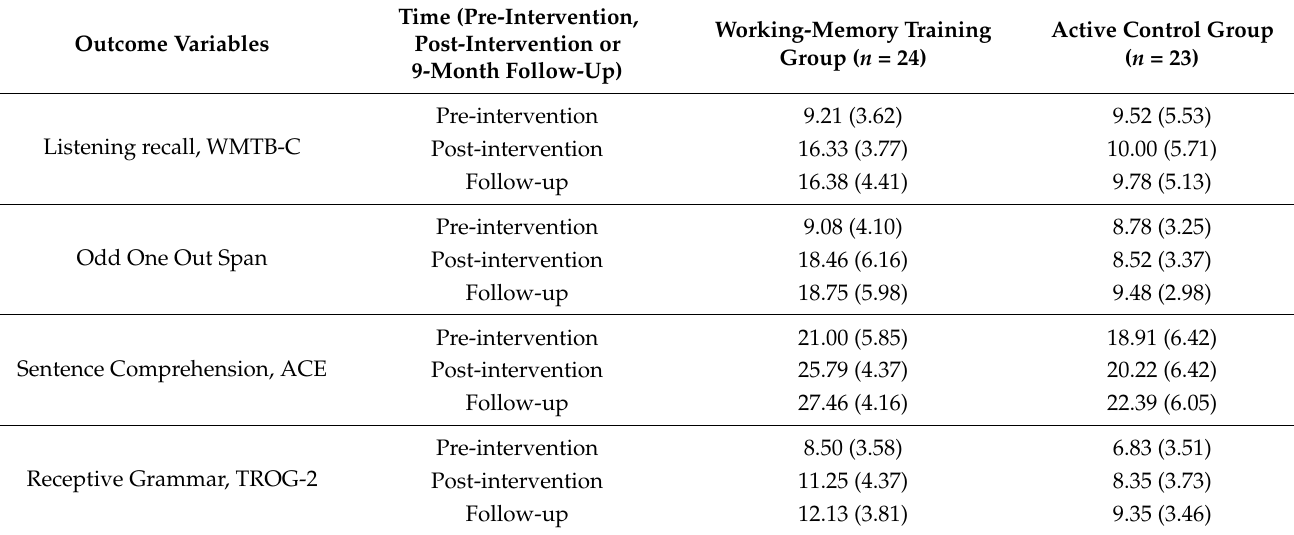
Table 2. Mean raw scores (SDs) for pre-intervention, post-intervention and 9-month follow-up on all outcome measures for children in the working-memory training and active control